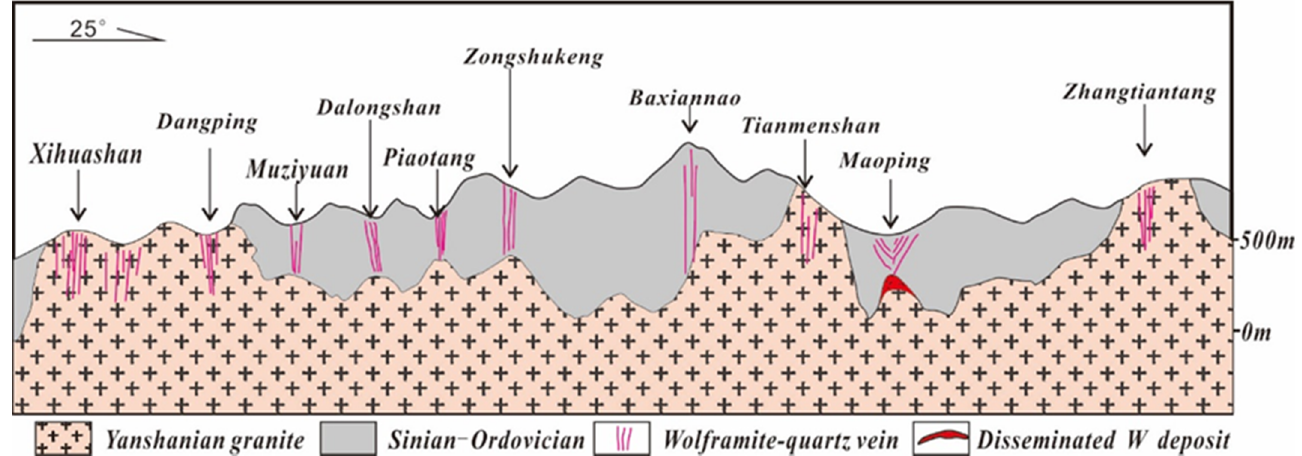
Figure 11. Geological profile of the Xihuashan-Zhangtiantang region of South China. Note that all wolframite-bearing quartz veins of economic value are located at similar specific horizontal elevations and intervals (modified after [172]).